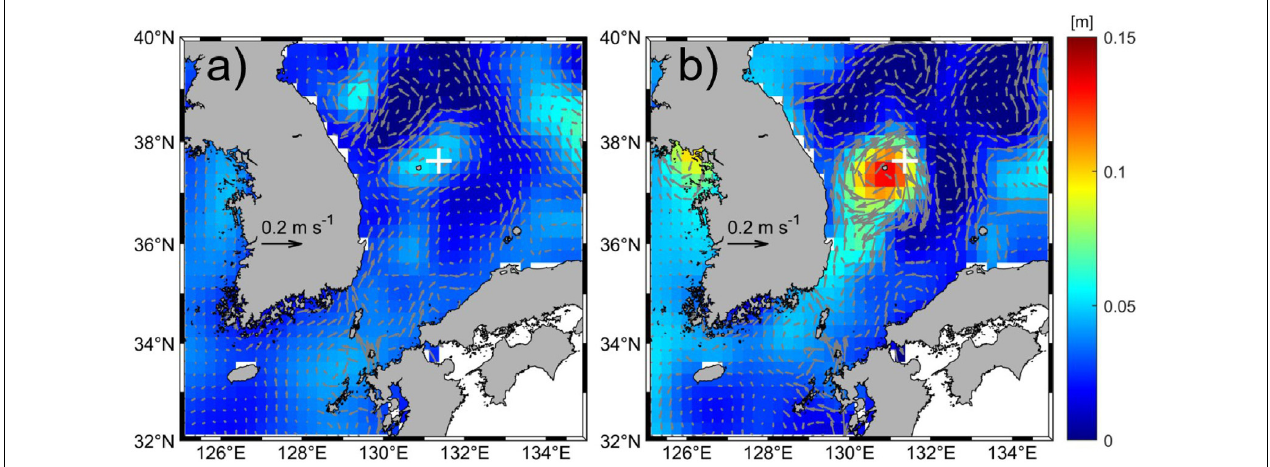
FIGURE 7 | Mean sea surface height (colors) and corresponding geostrophic surface currents (arrows) averaged over (a) the non-EN period from July 2011 to March 2014 and (b) the EN period from June 2014 to September 2016, estimated from the multi-mission altimeter-based gridded sea surface height data (horizontal resolution of 0.25 ◦ grid with error variance of 1.4 cm 2 ) of the Copernicus Marine Environment Monitoring Service (Taburet et al.,